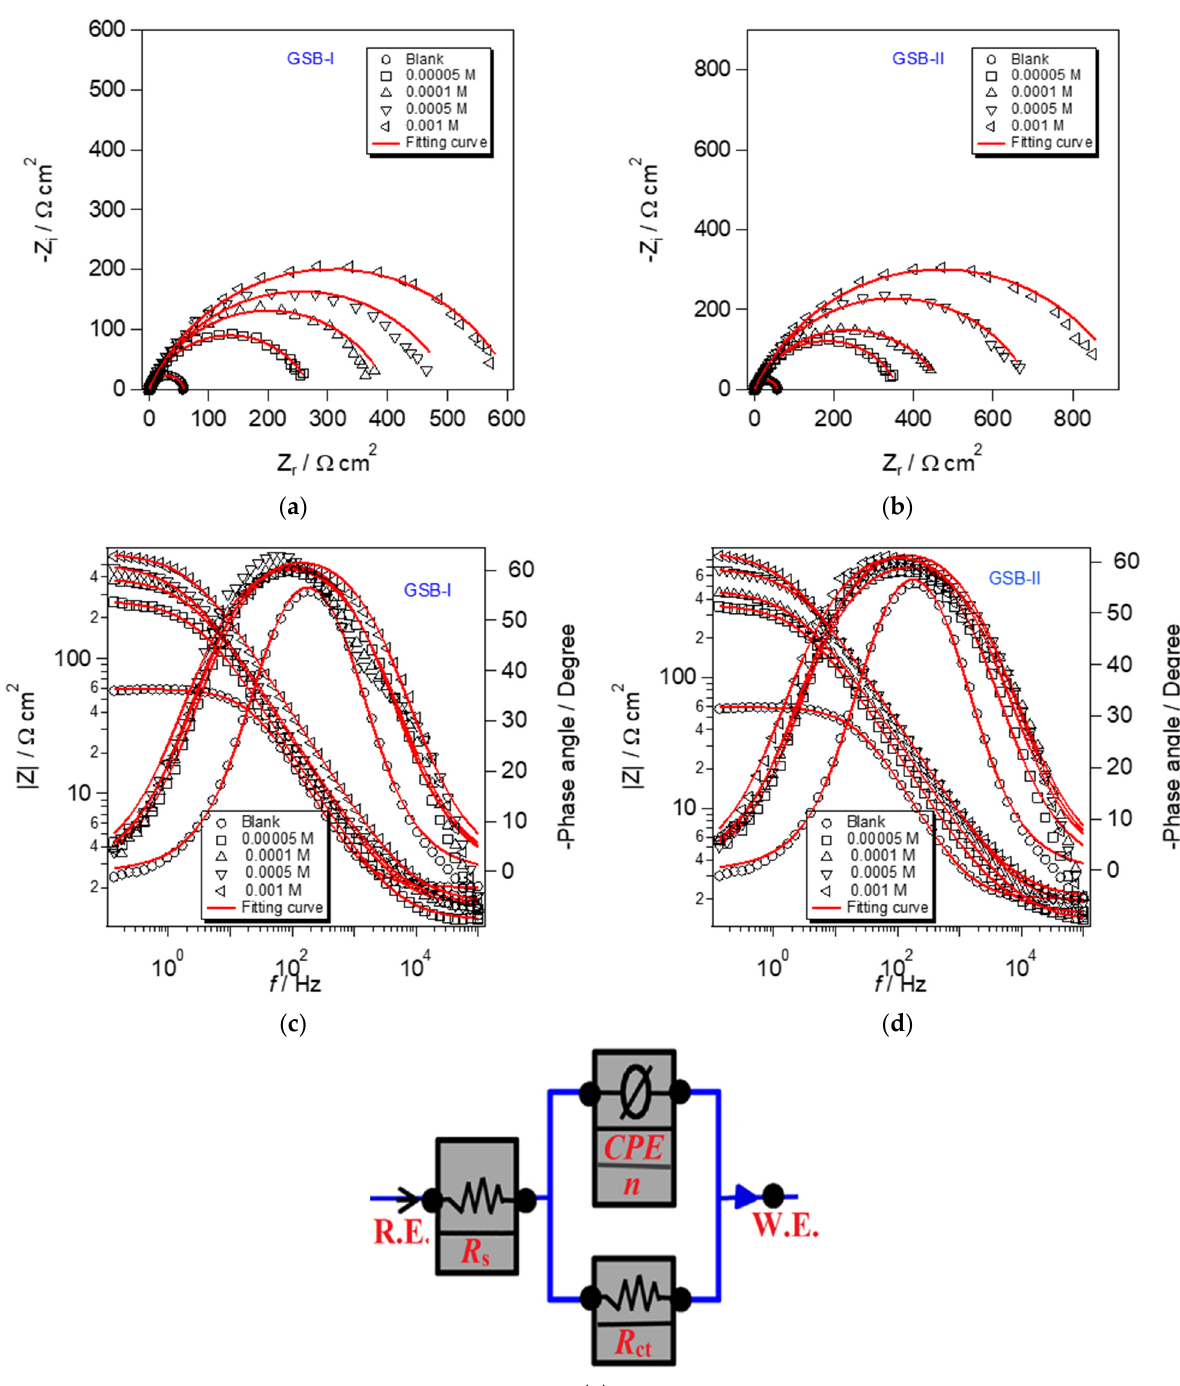
Figure 5. ( a , b ) Nyquist plot and ( c , d ) Bode modulus plot of EIS and ( e ) its equivalent circuit model for the API 5L X65 steel in 1 M HCl medium with different concentrations of the studied inhibitors at 298 K. Table 2. EIS factors for the API 5L X65 steel corrosion in 1 M HCl without and with different con- centrations of studied inhibitors at 298 K.